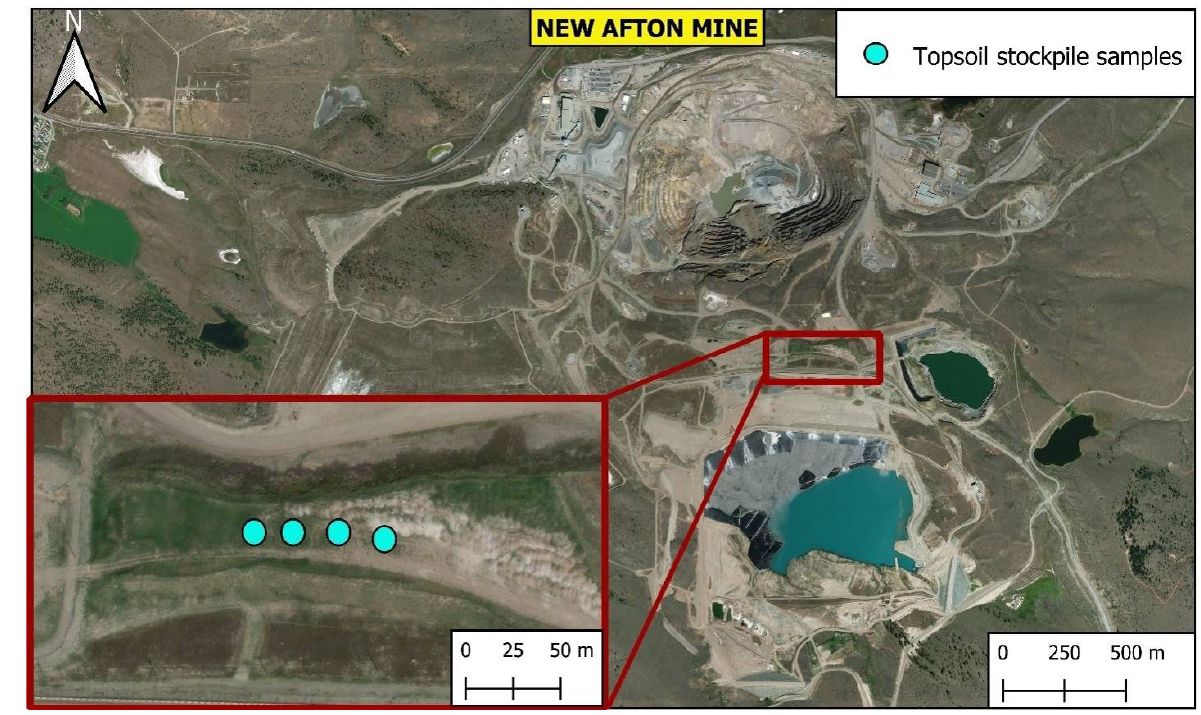
Figure 1. Aerial image of the New Afton mine site, including a close-up of the topsoil stockpile of interest that shows the locations of four soil core samples. Map generated in QGIS ® with Bing Virtual Earth background.